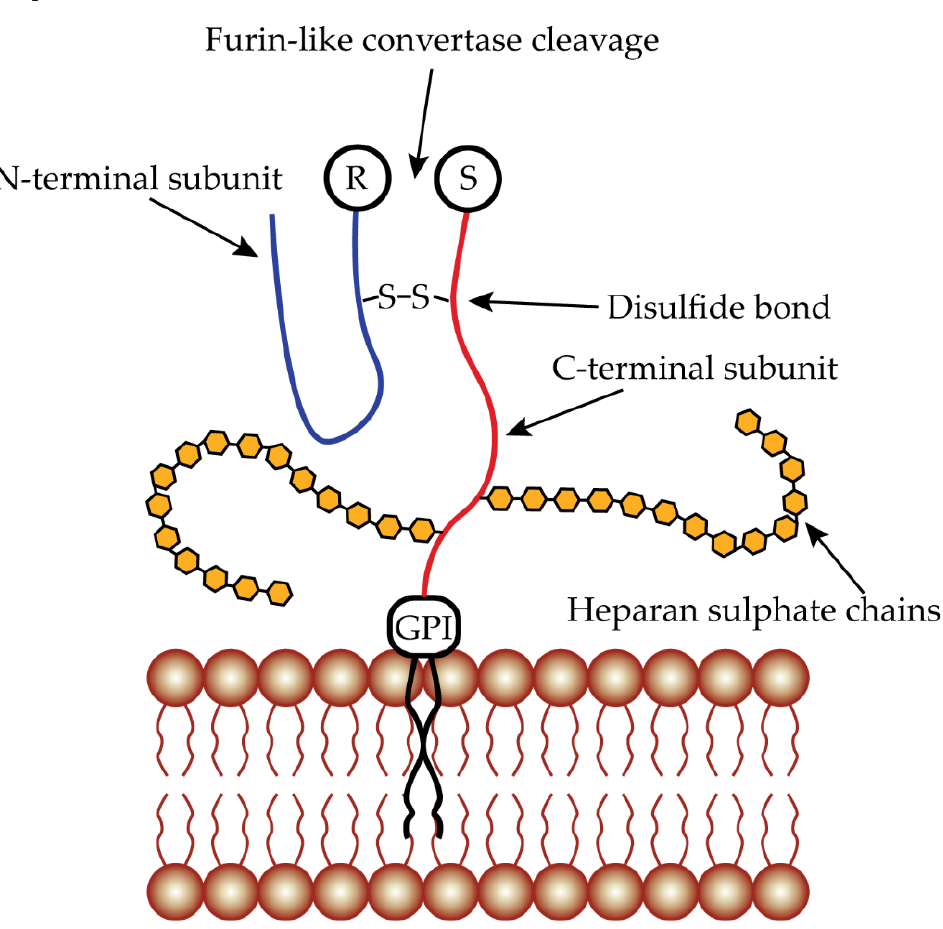
Figure 3. Glypican 3 structure. GPC3 protein presents a structure that similar to the other glypicans. A cleavage site for furin-like convertases is localized between Arg358 and Ser359. Once cleaved, two subunits are formed, bound to each other by a single disulfide bond. In the N-terminal subunit, there is the N-terminal secretory signal peptide while at the C-terminal subunit, there are two sites for the insertion of the HS chains at Ser495 and Ser509 and a GPI anchor at the end. The protein expression of GPC3 was also investigated. Capurro and colleagues ex- amined 29 HCC and 58 non-HCC samples [43]. In total, 21/29 and 1/58 of the HCC and non-HCC samples, respectively, were GPC3 positive. Normal liver tissues were negative [43]. A similar correlation was found in other studies evaluating 31, 55, 58, 56, and 49 HCC samples, with GPC3 positivity of 68%, 50.9%, 94.8%, 84%, and 75.5%, respectively, while normal tissues were negative for GPC3 [39,45–47,49]. GPC3 expression correlated with poor prognosis after surgical resection, earlier recurrence of HCC, and increased risk of death for HCC patients, and was defined as an independent prognostic factor for poor disease-free survival in patients with early HCC [45,48]. A signal corresponding to the GPC3 protein was found in both the cytoplasm and membrane, with a granular pattern near the cell membrane